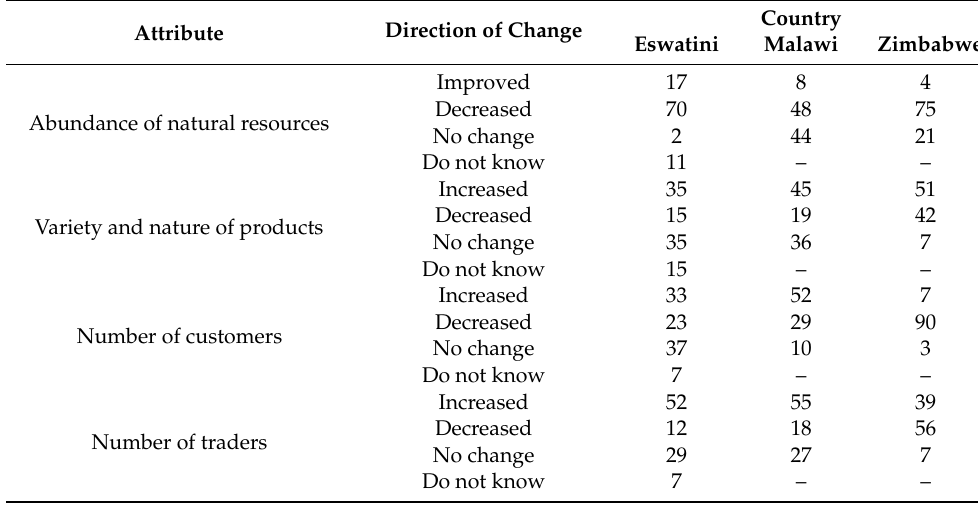
Table 4. Traders’ perceptions on trends in resource availability, variety and nature of crafts, number of traders and customers over the previous 7